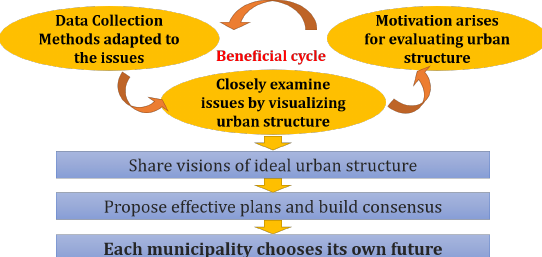
Figure 12. Concept of widespread deeper examination